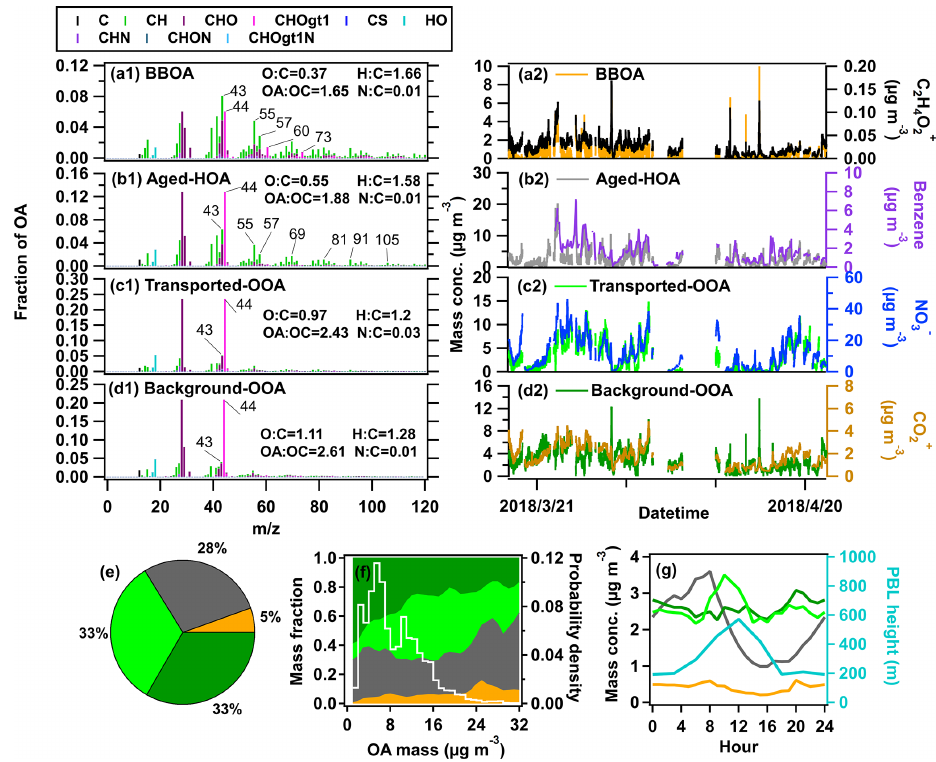
Figure 4. Mass spectra (left) and time series (right) of four OA factors: (a1, a2) BBOA, (b1, b2) aged-HOA, (c1, c2) transported-OOA, (d1, d2) background-OOA. Time series of tracers associated with each factor are also displayed. (e) Average chemical compositions of OA. (f) Variations of OA compositions and probability density as a function of OA mass concentration. (g) Average diurnal variations of OA factors and planetary boundary layer (PBL) height during the whole campaign.